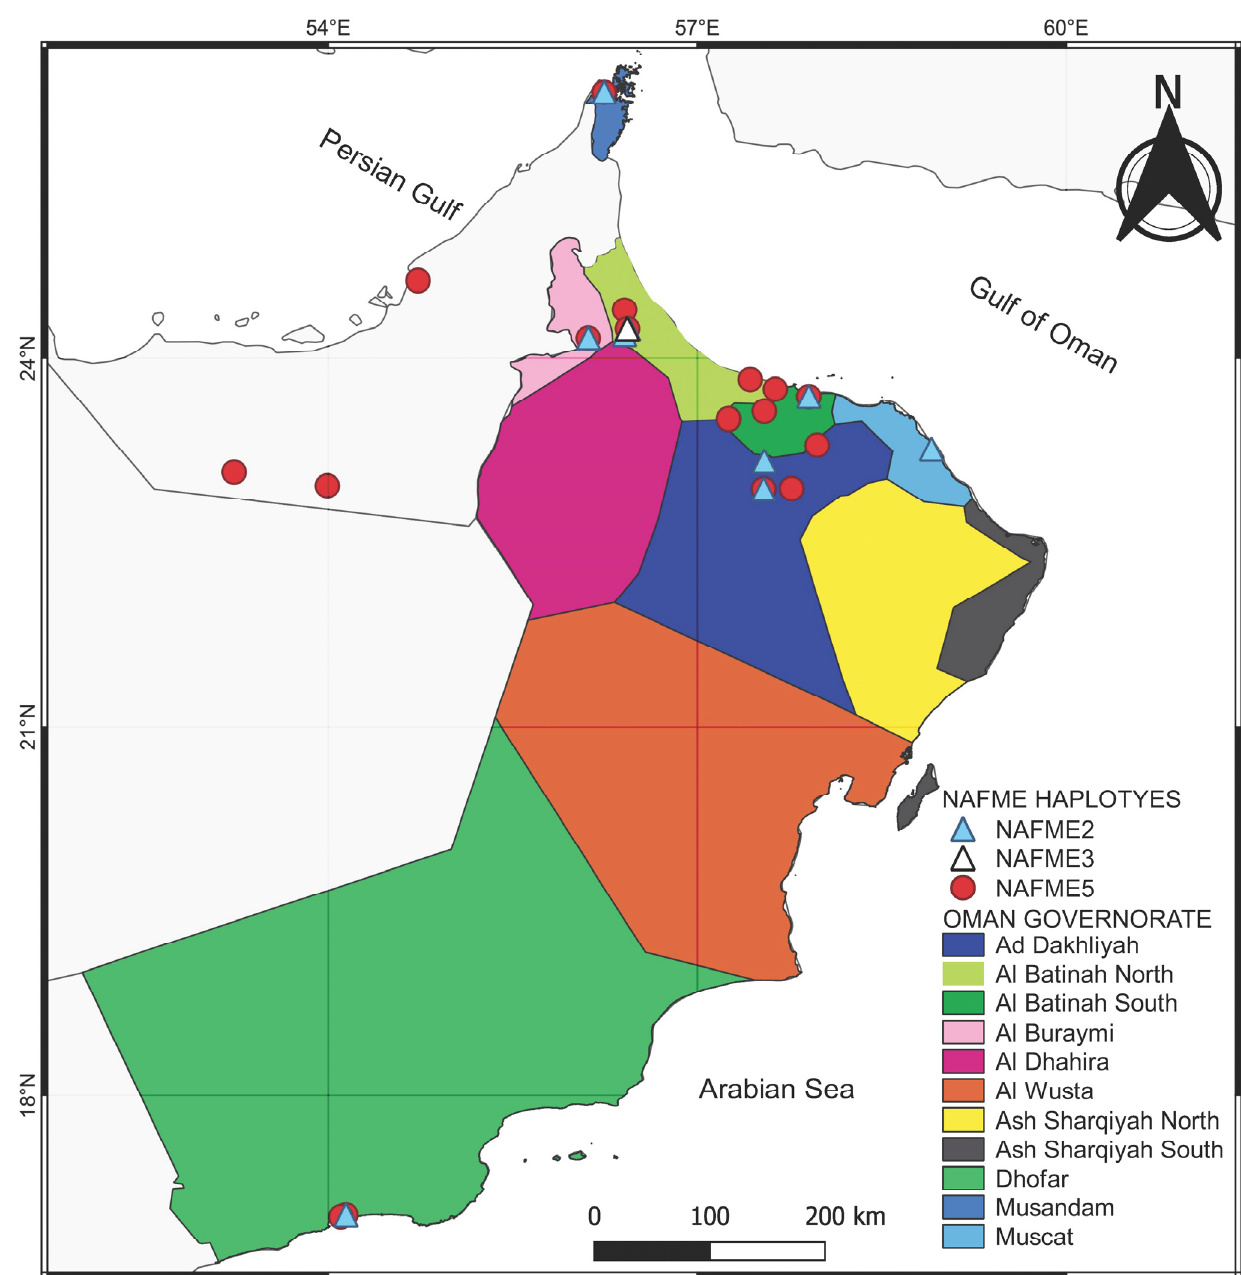
Figure 2. The distribution of the Bemisia tabaci belonging to the North Africa–Middle East (NAFME) cryptic species in Oman.